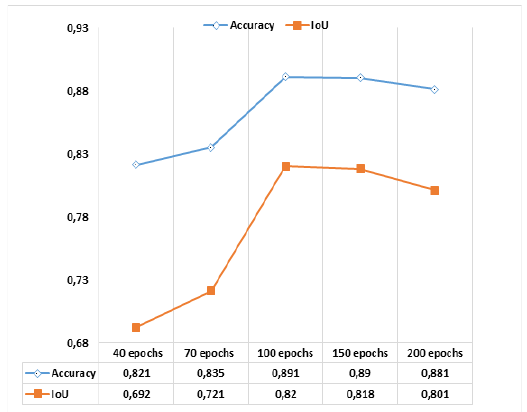
Figure 9. Sensitivity of the number of epochs on the performance of the